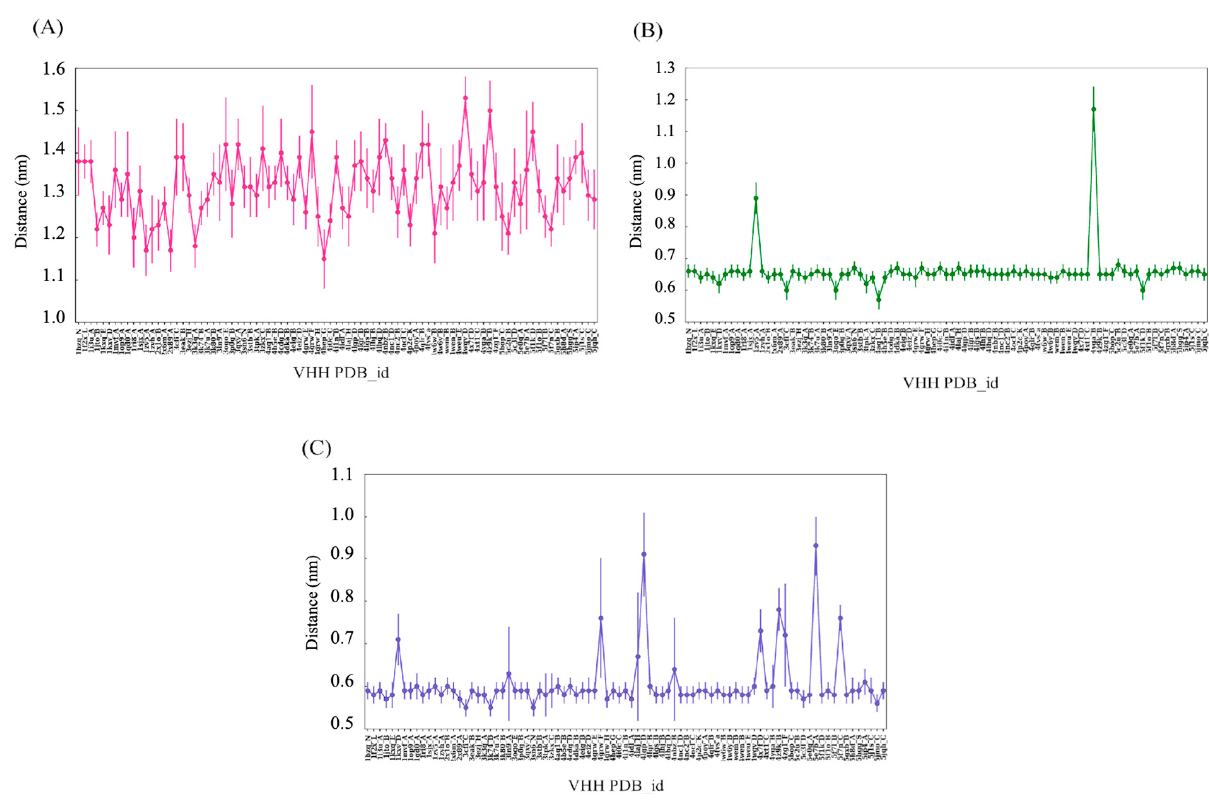
Figure 9. Mean of Distance between CDRs termini in each V H H trajectory. ( A ) CDR1, ( B ) CDR2 and ( C ) CDR3